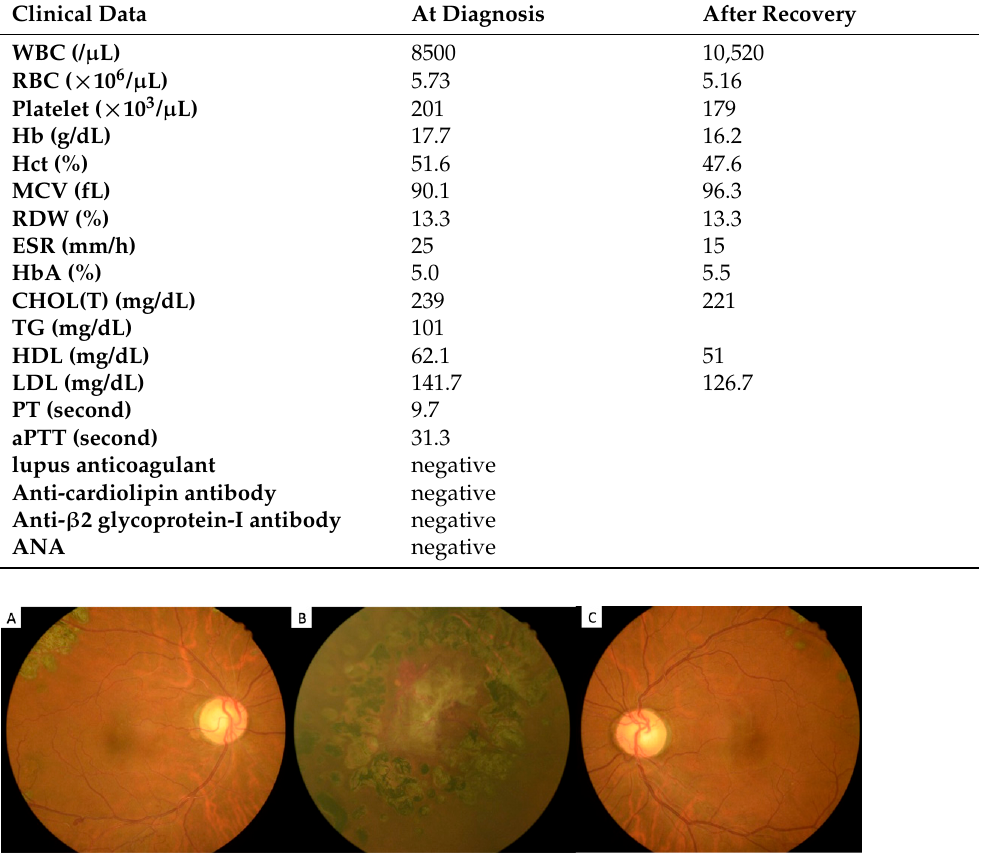
Table 1. Retinopathy aossociated with sickle cell anemia, diabetes mellitus, coagulopathy, throm- bophilia disease such as antiphospholipid syndrome and autoimmune disease can be ruled out. Clinical Data At Diagnosis After Recovery Figure 2. ( A ) Fluorescence stains with surrounding non-perfusion area due to laser treatment at temporal upper and some neovascular lesion on the peripapillary area in the right eye; and ( B ) Dif- fuse fluorescence leakage at late stage in the right eye.